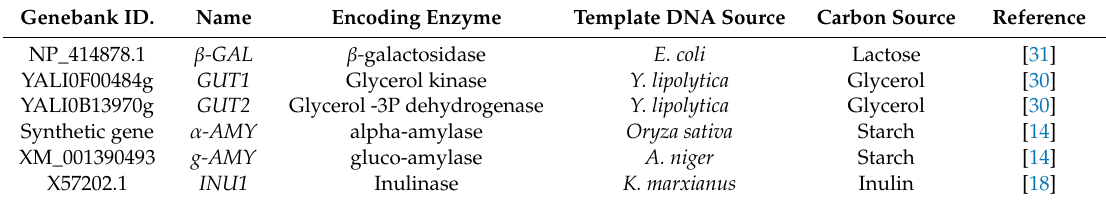
Table 2. Genes overexpressed for raw carbon